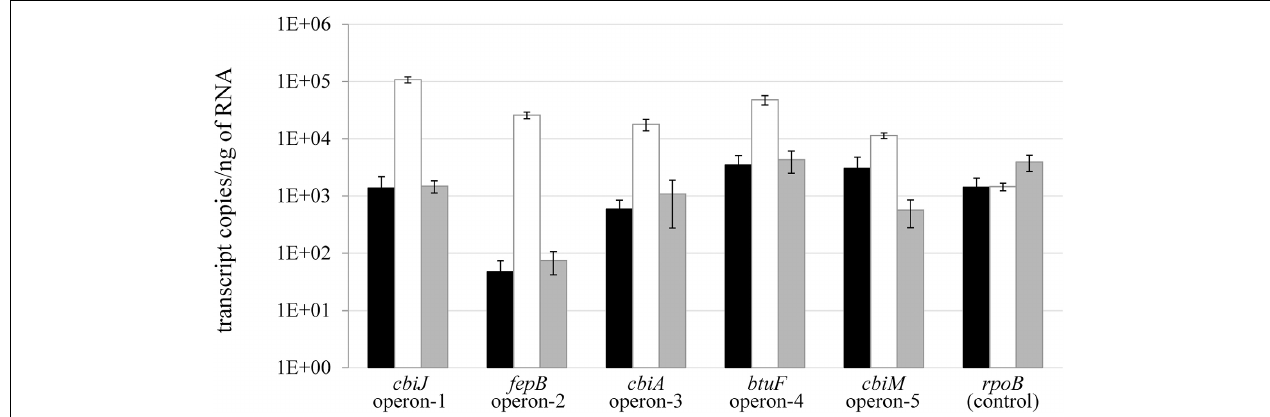
FIGURE 4 | Transcriptional analysis of cobalamin riboswitch- dependent genes in D. restrictus . The transcription of the genes located directly downstream of the cobalamin riboswitches in operon-1 to -5 was analyzed. The housekeeping gene rpoB was used as unregulated control. The black bars indicate the transcriptional level